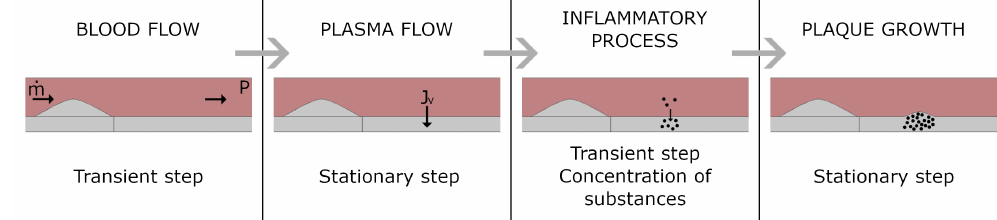
Figure 3. Pathline of the computational